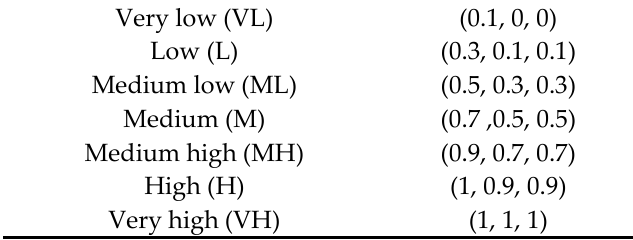
Table 2. Linguistic variables for the importance weight of each criterion.